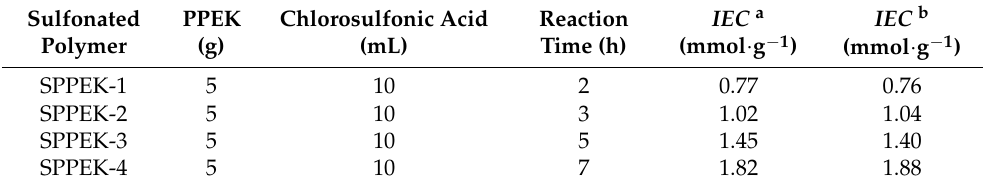
Table 1. The conditions and results of sulfonation reaction.